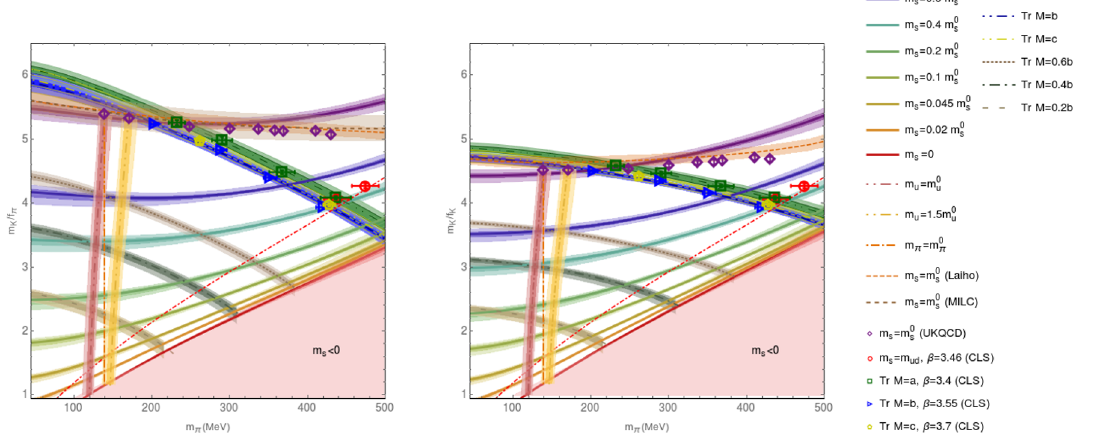
Figure 14 . Decay constant ratios, m K =f (cid:25) and m K =f K , obtained in Fit IV in comparison with the lattice